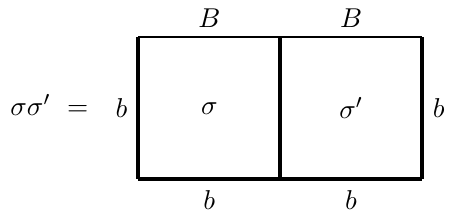
Figure 3 . Definition of the product in π 2 ( A, B ; b ) , which is given by horizontal concatenation.